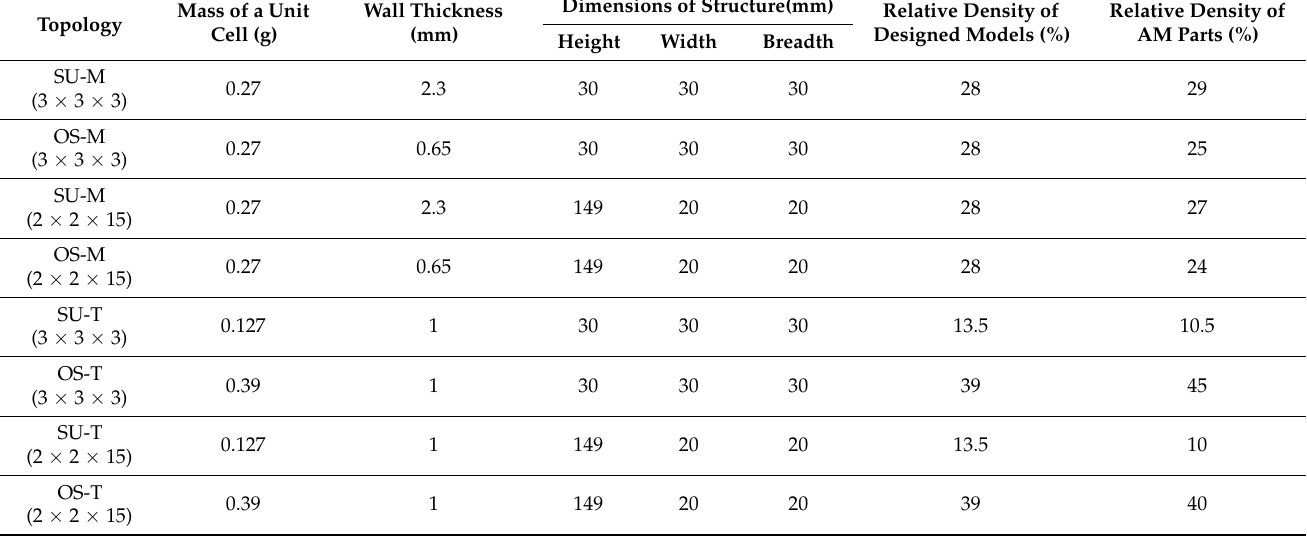
Table 1. The complete dimension of all the